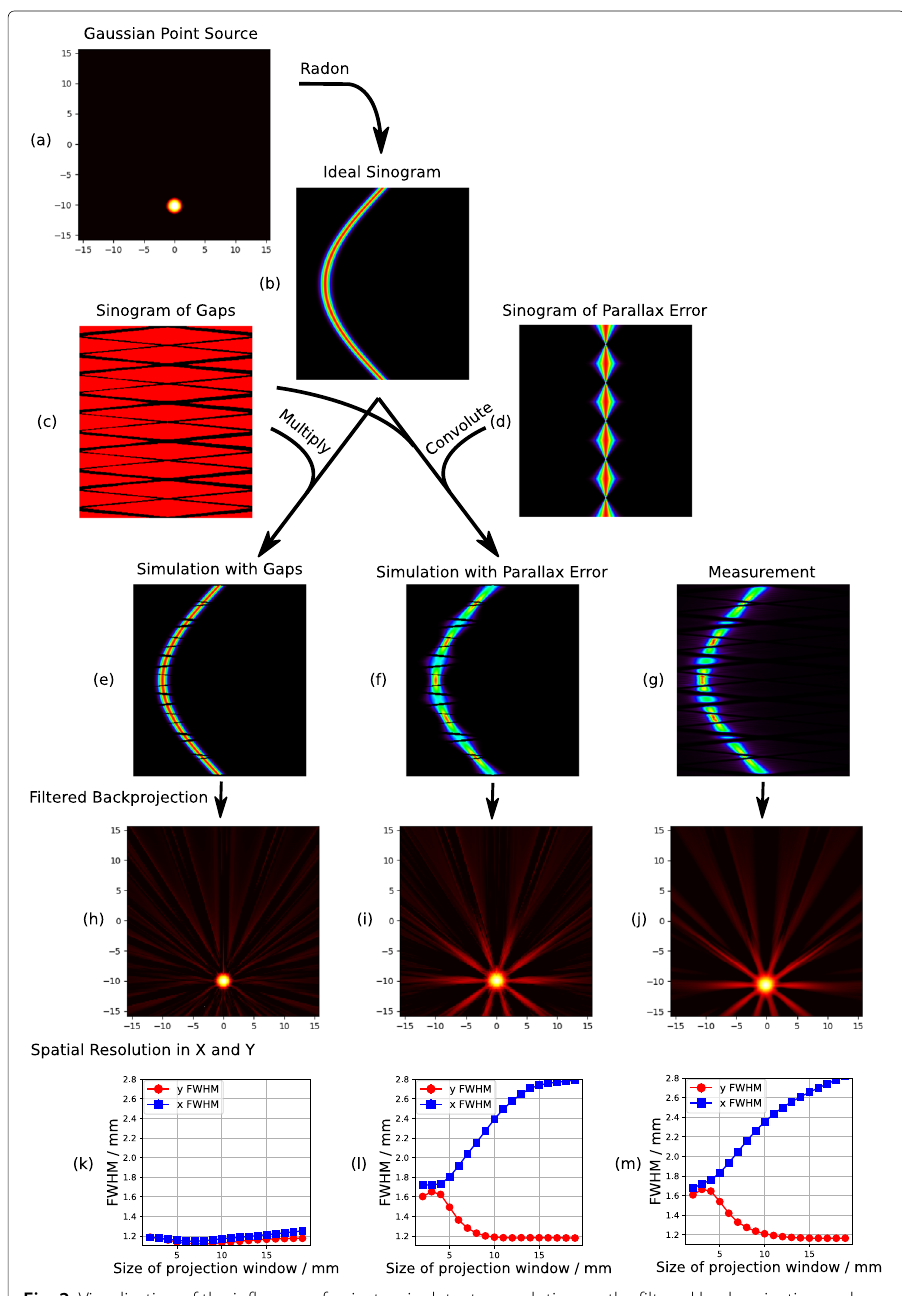
Fig. 2 Visualization of the influence of anisotropic detector resolution on the filtered backprojection and resulting spatial resolution along the two axis. e , h , k The simulation with only gaps. f , i , l The simulation with anisotropic detector resolution and gaps of 10 detector modules. g , j , m A measurement. The simulation with anisotropic detector resolution and the measurement exhibit a star-like artifact in the reconstruction, which leads to a split in spatial resolution along x and y axis, as shown in the bottom row